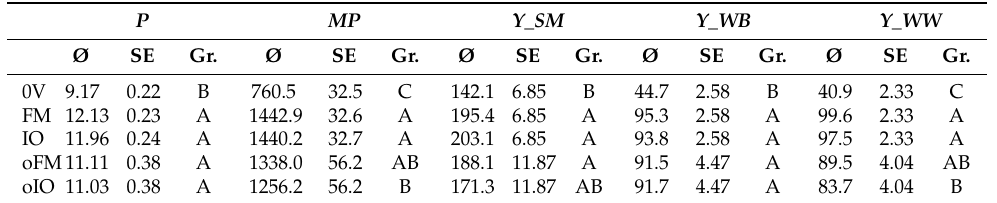
Table 4. Mean values (Ø), standard errors (SE), and Tukey groups (Gr.) for protein content ( P ), market performance ( MP ), and crop yields ( Y ) for five factor levels of fertilization.